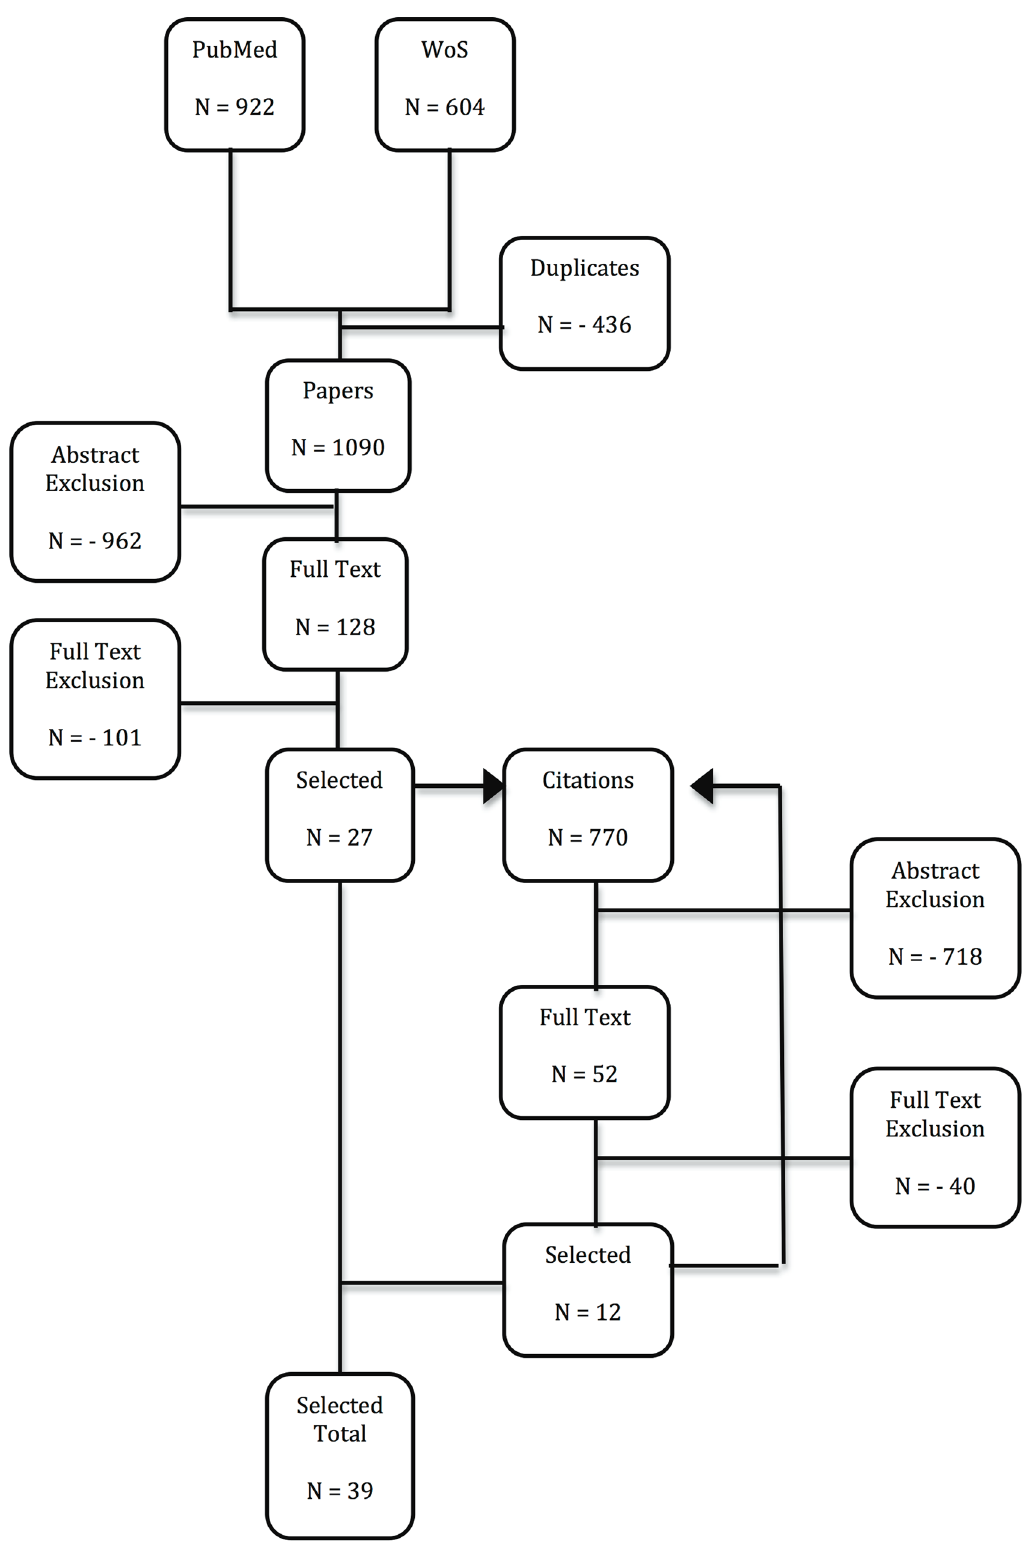
Figure 1. Modified PRISMA flow diagram. PubMed and Web of Science (WoS) search results were combined and after controlling for duplicates, titles and abstracts from references were screened for further full text assessment. Citations from and to the selected references were also screened using title and abstract for further full text assessment. Citations from and to the additional selected references were again screened as discussed. The additional selected references thus found were added to the earlier found references in order to obtain the Selected Total.